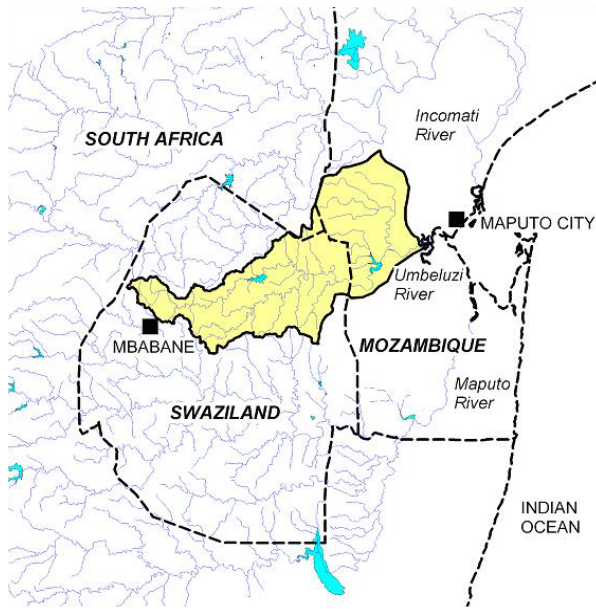
Figure 1 The Umbeluzi River basin Fig. 1. The Umbeluzi River basin.